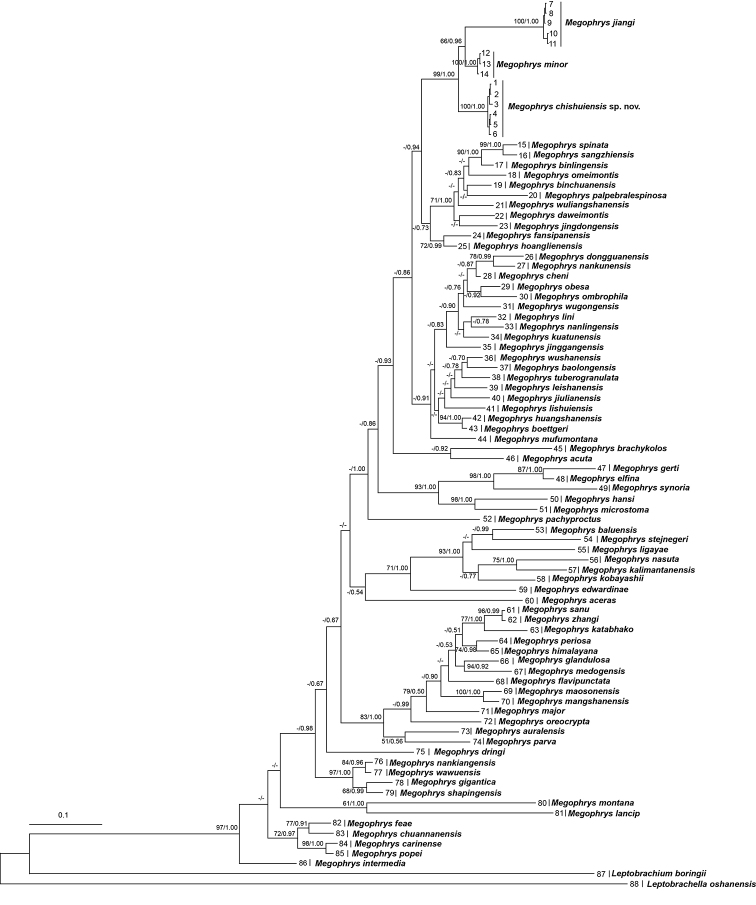
Maximum likelihood (ML) tree of the genus Megophrys reconstructed based on the 16S rRNA and COI gene sequences. Bayesian posterior probability/ML bootstrap supports were denoted beside each node. Samples 1–88 refer to Suppl. material 2: Table S2.